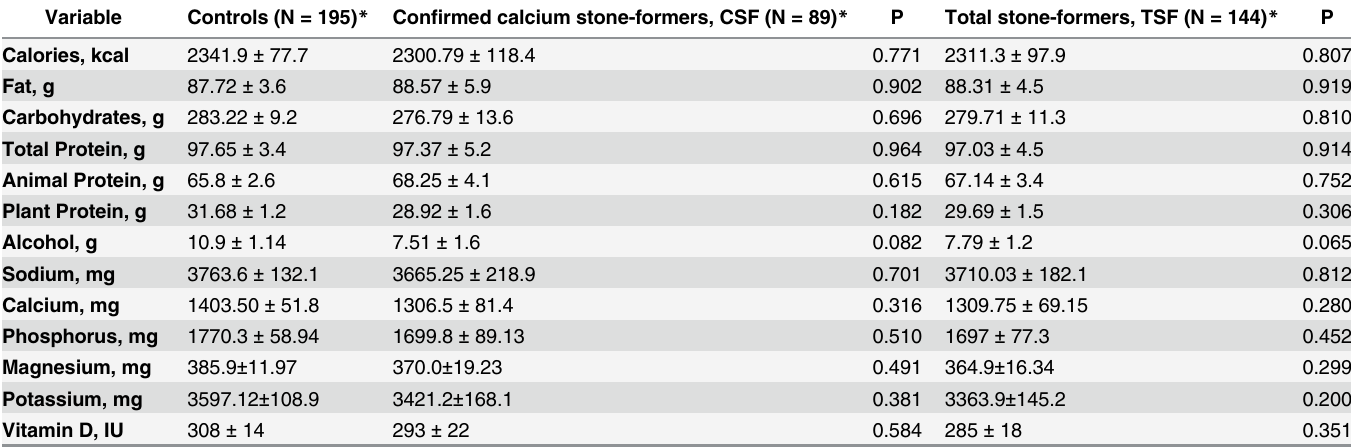
Table 4. Dietary intake variables in calcium stone-formers and controls. All values are represented as mean ± standard error. CSF = confirmed; TSF = total (confirmed plus presumed calcium SF).